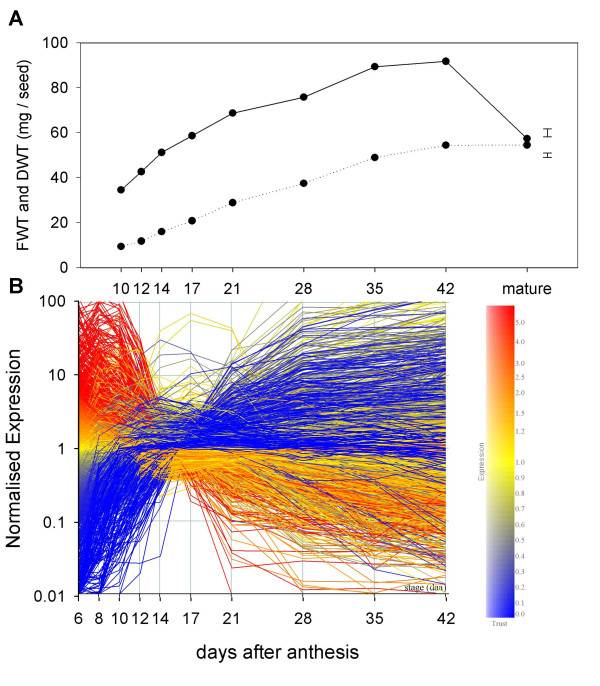
Data from two biological replicate samples of developing wheat caryopses. Upper panel: grain fresh weight and dry weight (error bars are least significant difference at P < 0.05 from 1-way analysis of variance). Lower panel: transcriptome of samples measured on wheat Affymetrix arrays. Each line depicts average signal from two replicate samples for a probeset coloured according to expression at 6 days after anthesis (daa). Gene set is those showing significant (P < 0.05; Benjamini-Hochberg false discovery rate multiple-testing correction) differences in expression between stages (14,550 probesets).